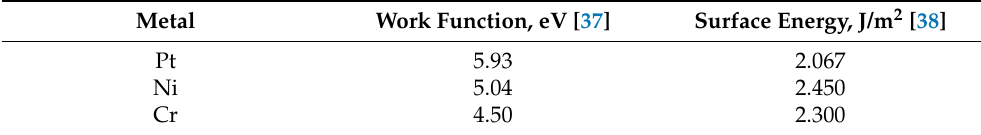
Table 4. Work function and surface energy of metallic Pt, Ni, and Cr.